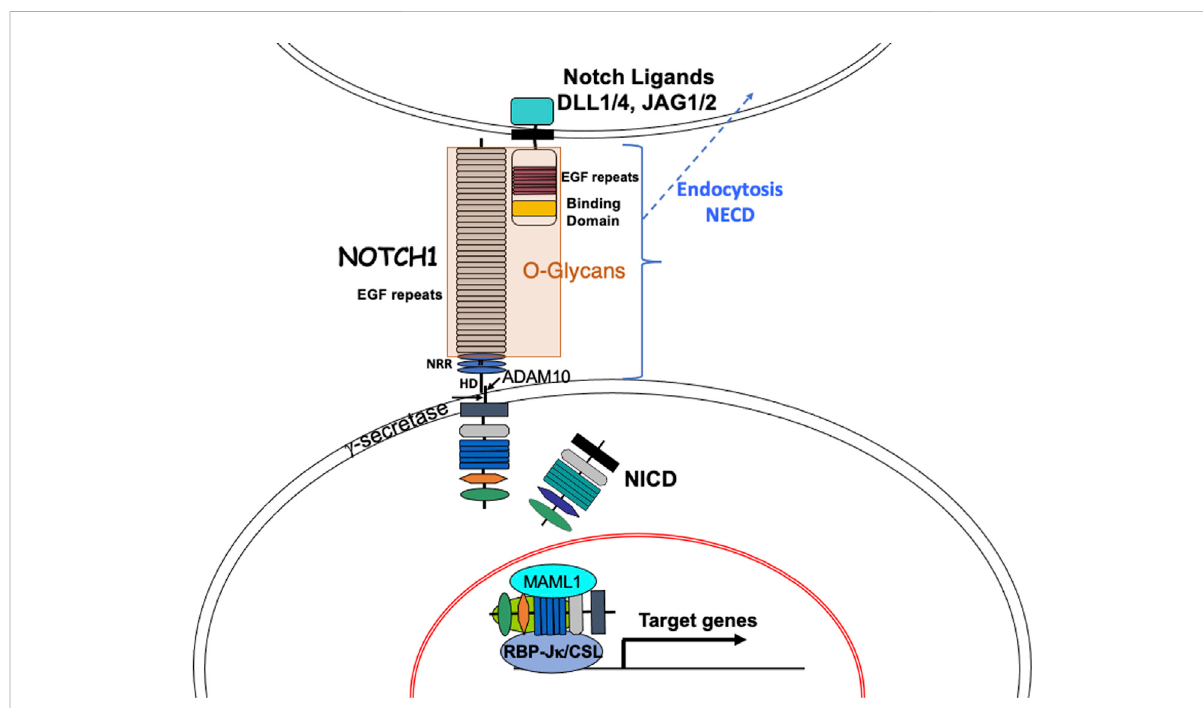
FIGURE 1 TheNotchsignalingpathway.ThebasiccomponentsoftheNotchsignalingpathwayareshown.CanonicalNotchligandsDLL1,DLL4,JAG1and JAG2 in a signal-sending cell contact heterodimeric Notch receptors (e. g. NOTCH1) in a signal-receiving cell to initiate Notch signaling. Binding of ligand to NOTCH1 is regulated by O-glycans on EGF repeats of the Notch ECD and induces a conformational change that exposes a juxta- membrane cleavage site for the metalloprotease ADAM10. The released Notch ECD is endocytosed into the signal-sending cell. The transmembrane remnant of NOTCH1 is then cleaved within the membrane by gamma-secretase. The released Notch ICD transits to the nucleus where it combines with RBP-J κ /CSL and transcriptional activators including MAML1 to form a complex that recognizes RBP-J κ /CSL DNA binding sites in many target genes, thereby activating transcription. Notch signaling target genes include transcriptional suppressors like Hes and Hey family genes and transcriptional activators like c-Myc. NRR, Notch regulatory domain; HD, heterodimerization